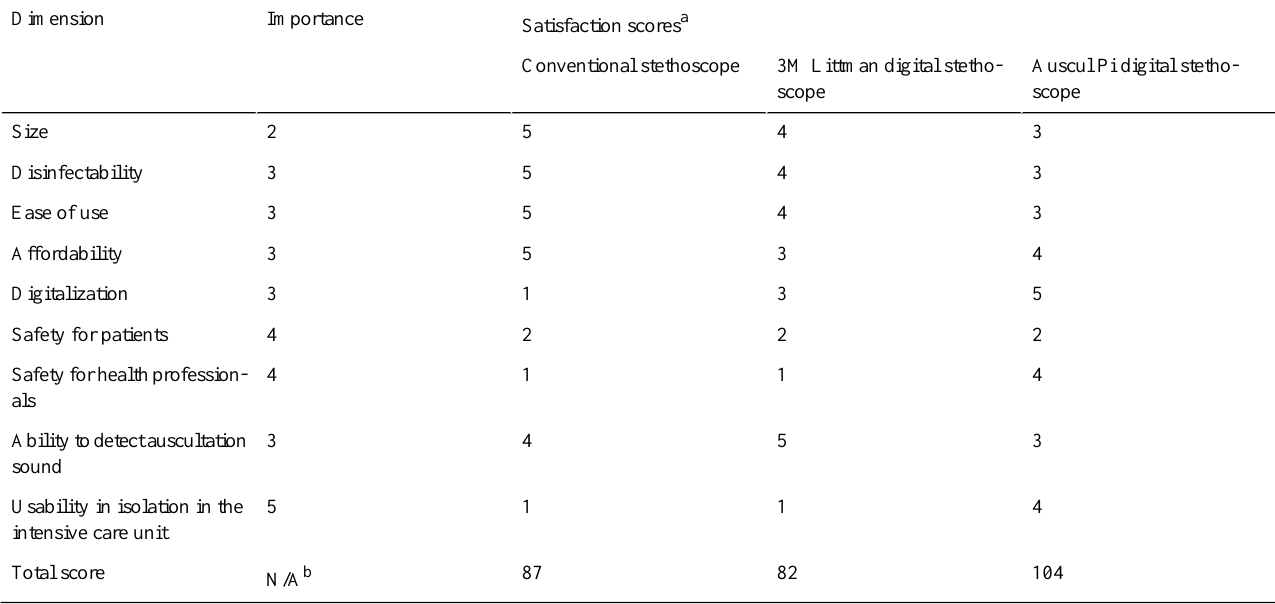
Table 2. Engineering design matrix showing the importance and satisfaction scores of various dimensions of the stethoscopes from 1-5 (1, weakest; 5,